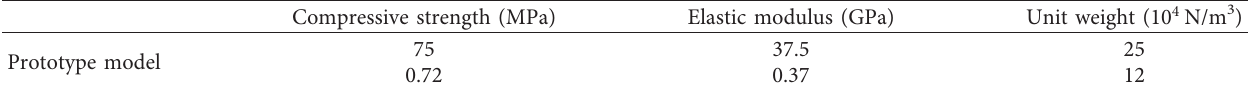
Table 4: Mixture ratios and properties of admixture of sand and olefin.